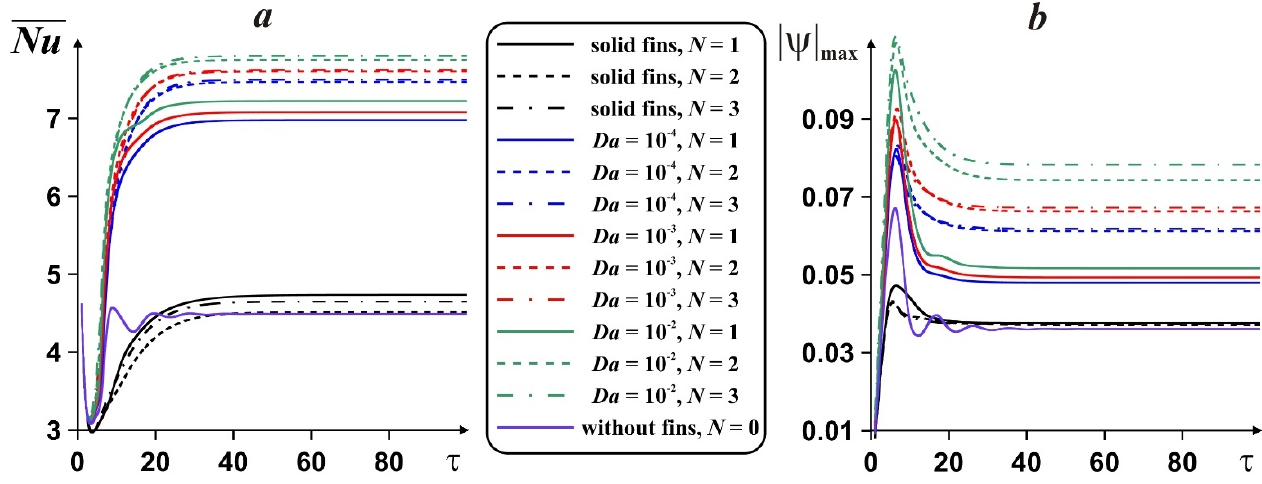
Figure 6. Time evolution of average Nusselt number ( a ) and fluid flow rate ( b ) on number of fins, material of fins and Darcy number for porous fins.